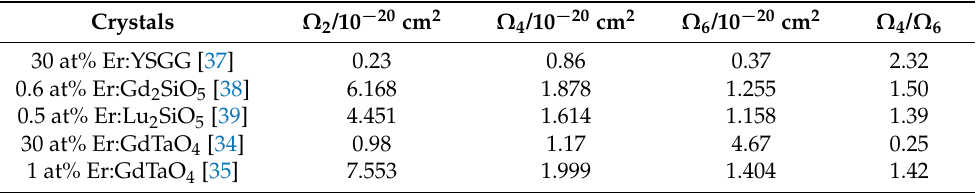
Table 2. Comparison of Ω t values with other Er-doped hosts.